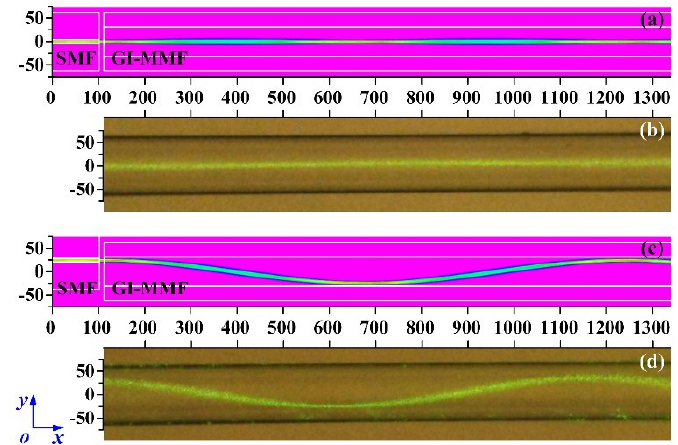
Figure 2. The simulated ( a ) and experimental ( b ) beam path in the graded-index multimode fiber (GI-MMF) under a displacement of 0 µm; the simulated ( c ) and experimental ( d ) beam path in the GI-MMF under a displacement of 25 µm.